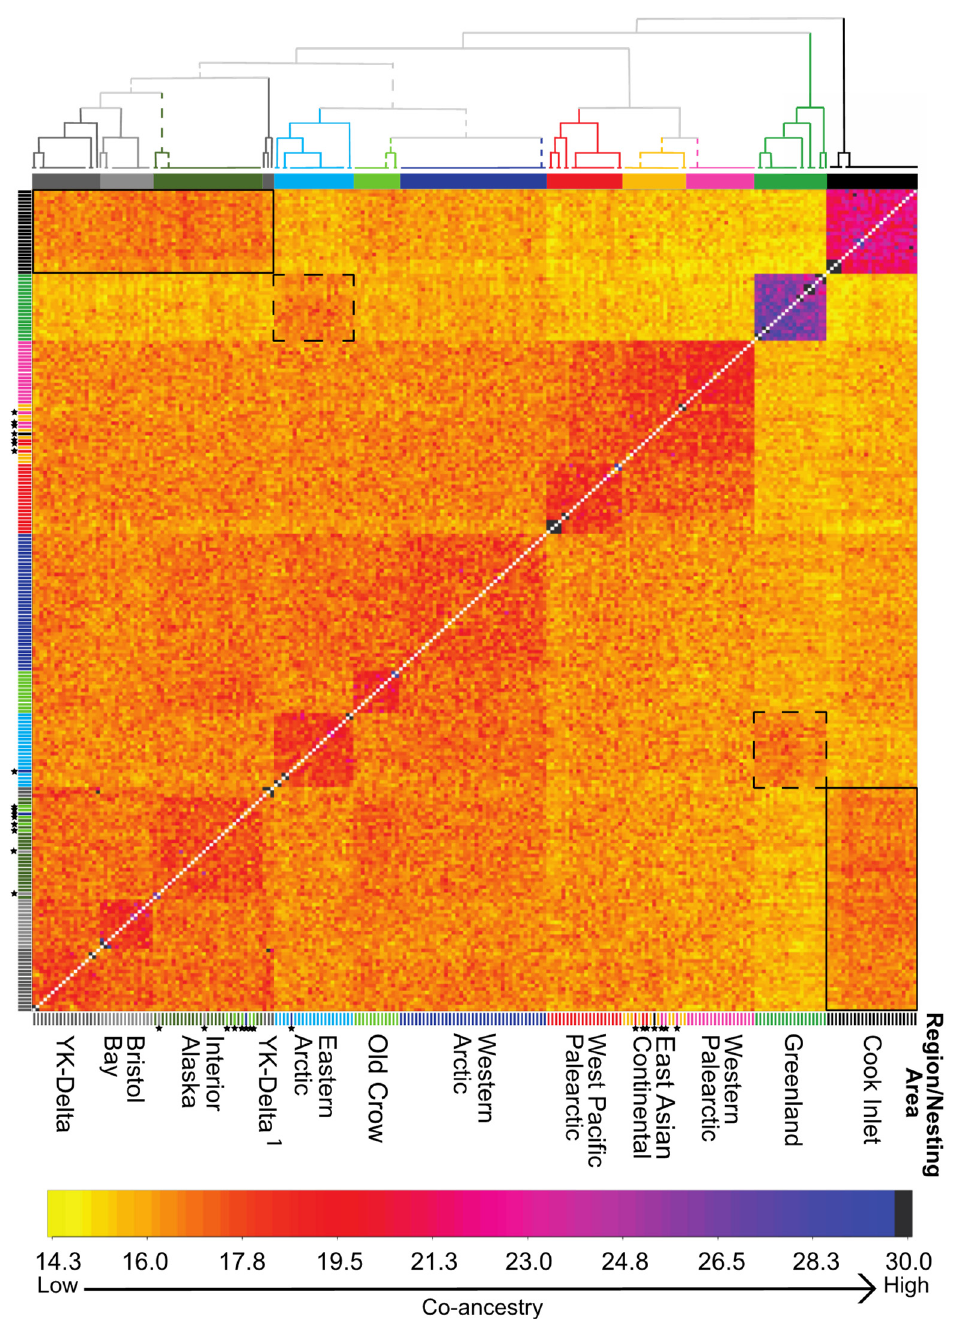
Figure 3. FineRADstructure co-ancestry matrix illustrating the degree of pairwise co-ancestry be- tween greater white-fronted goose individuals. Inferred populations, corresponding to clusters in the accompanying dendrogram, are denoted by color blocks (top), which generally coincide with geographic regions. Nodal support in the dendrogram is >0.95 posterior probability for solid lines with <0.95 support shown as dashed lines. Nesting areas for individual samples are denoted with colored bars at bottom and left. An asterisk identifies individuals assigned to clusters that primarily represent other areas. The solid outline highlights evidence of elevated co-ancestry between Cook Inlet and other populations in Alaska, whereas the dashed box highlights elevated co-ancestry be- tween Greenland and eastern Canada. The color scale for co-ancestry values was capped at 30 to enhance the visualization of small differences in population level co-ancestry; values > 30 were ob- tained only for a few within-population comparisons, most of which reflect the presence of closely related individuals in the dataset (see Supplemental Figure S4).